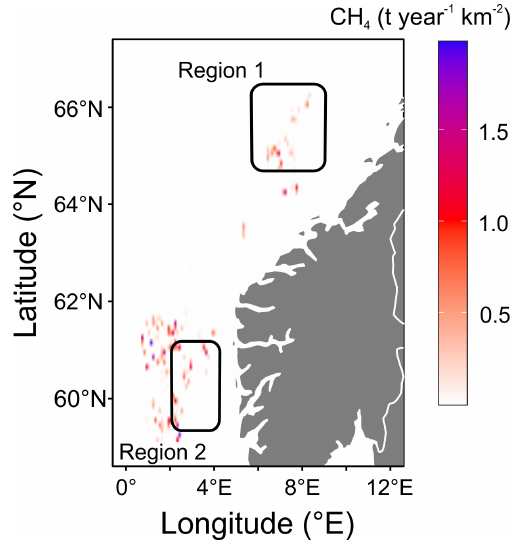
Figure 3. Spatially gridded CH 4 emissions from fuel exploitation for the northern North Sea and Norwegian Sea (Scarpelli et al., 2020). Regions surveyed in this study are represented by the boxes labelled “Region 1” and “Region